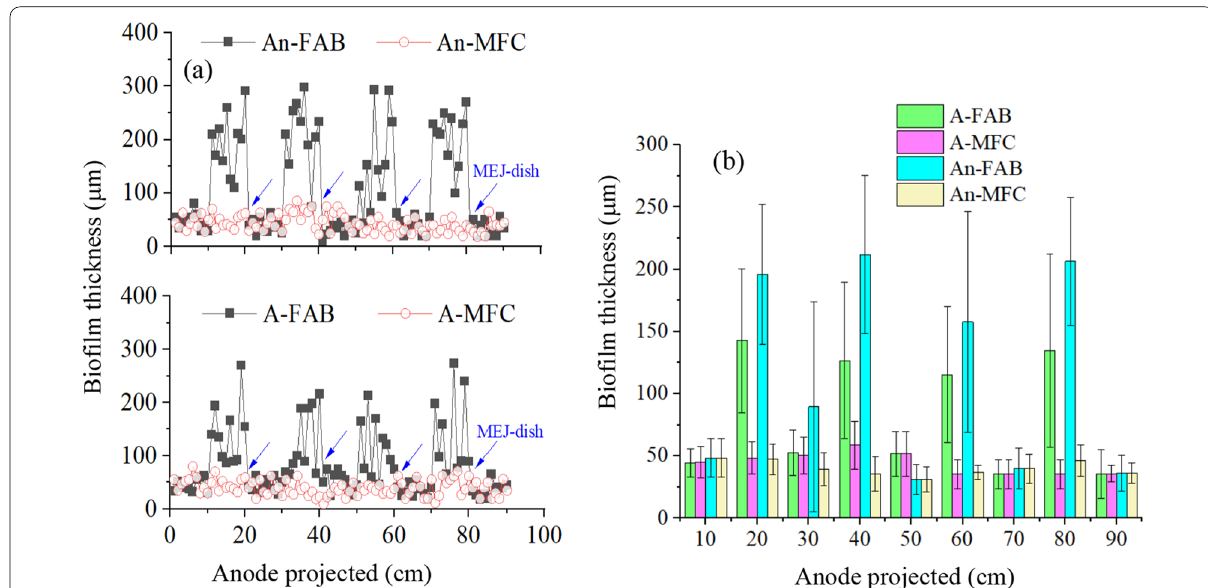
Fig. 10 The anode biofilm thickness (BT) profile in the aerobic-MFC (A-FAB and A-MFC) and anaerobic (An-Fab and An-MFC) integrated system. The overall a BT distribution and b mean SD. Each data point indicates the top BT within multiple measurements of n independent biofilms ± (5 n 10) per 10 mm distance excluding outliers, but not the exact spatial and temporal BT distribution on the electrode. The arrows indicate ≤ ≤ MEJ-dish inserted location on the anode. FAB fragmented anode